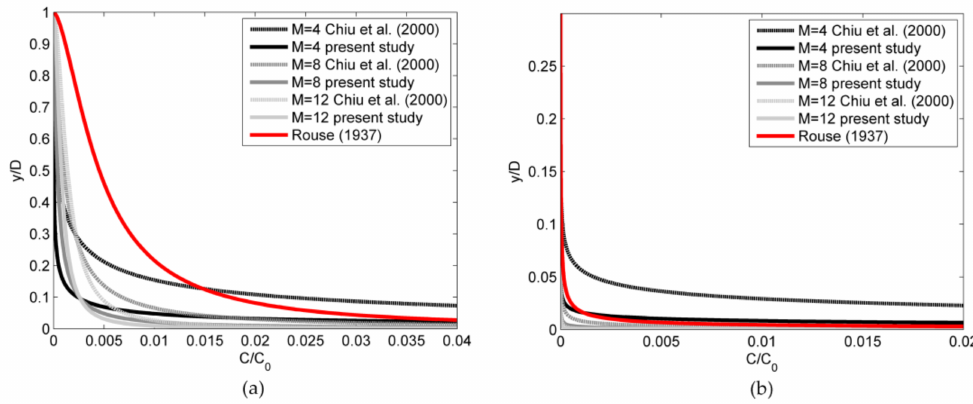
Figure 7. Comparison among the prediction by Equation (6) by Rouse [12], Equation (9) by Chiu et al. [30], Equation (21): ( a ) d = 0.075 mm from Valiani’s data set ( λ = 5.9) and ( b ) d = 0.150 mm from Valiani’s data set ( λ =